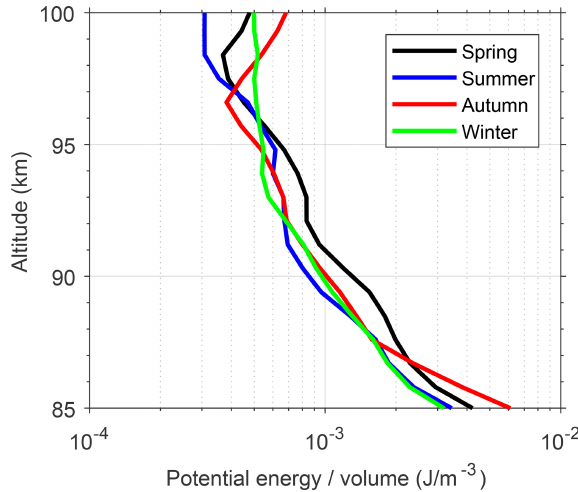
Figure 10. Vertical profiles of the potential energy per unit volume (in Jm − 3 ) averaged over spring (13 weeks mean centered at vernal equinox, shown by the black line), summer (13 weeks mean cen- tered at summer solstice, shown by the blue line), autumn (13 weeks mean centered at autumn equinox, shown by the red line), and win- ter (13 weeks mean centered at winter solstice, shown by the green